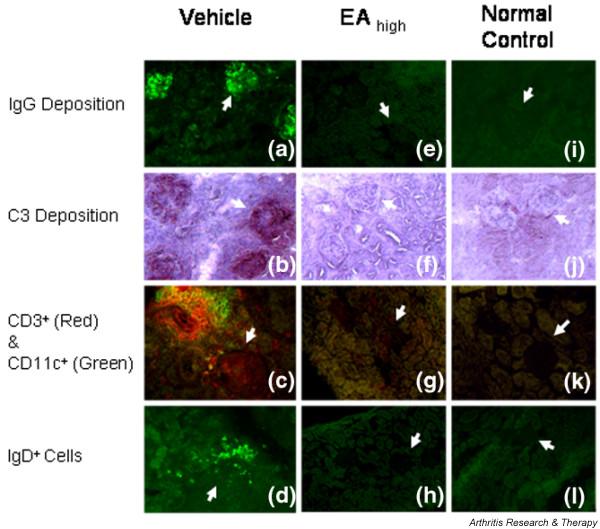
Immunohistochemical analysis of the kidney of NZB/WF1 mice after treatment with (a-d) vehicle or (e-h) the ethyl acetate (EA) extract of Tripterygium wilfordii Hook F. Kidney was examined for deposition of (a,e,i) IgG, (b,f,j) complement 3 (C3) and infiltration of (c,g,k) CD3+ cells (in red) and CD11c+ cells (in green) and (d,h,l) IGD+ cells. Results shown are representative of five mice per group. Arrows indicate representative glomeruli.